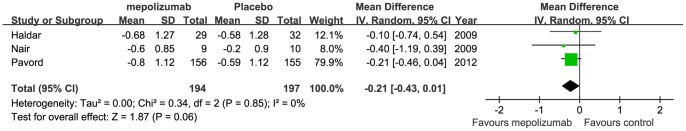
The effects of mepolizumab on Juniper Asthma Control Questionnaire (JACQ).